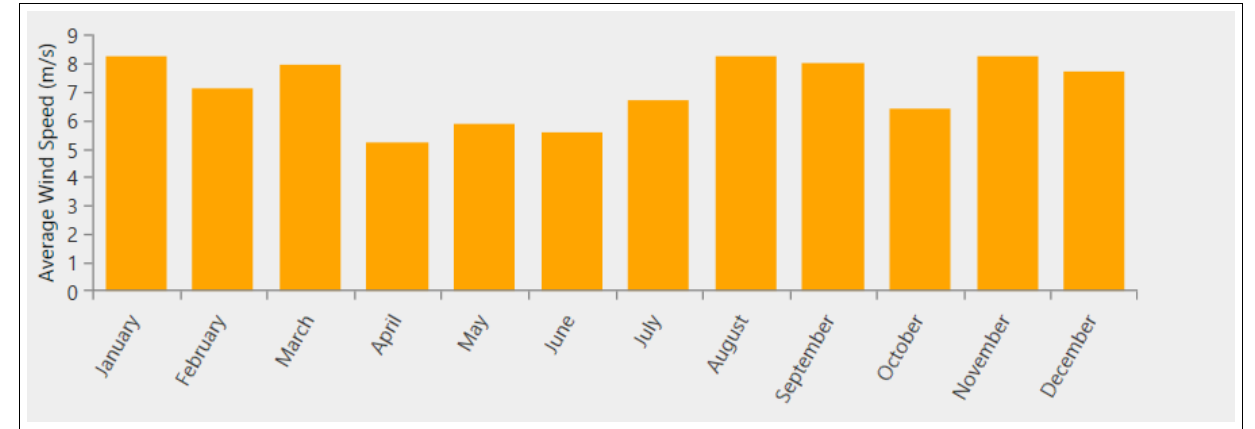
Figure 3. Monthly Solar Radiation Sources and Clearness Index.